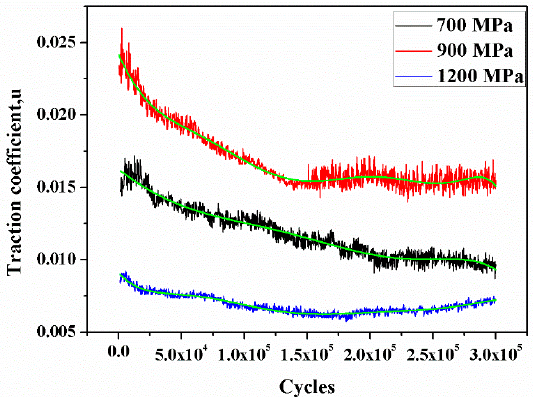
Figure 3. The variation of the traction coefficient under different contact stress conditions. Materials 2019 , 12 , x FOR PEER REVIEW